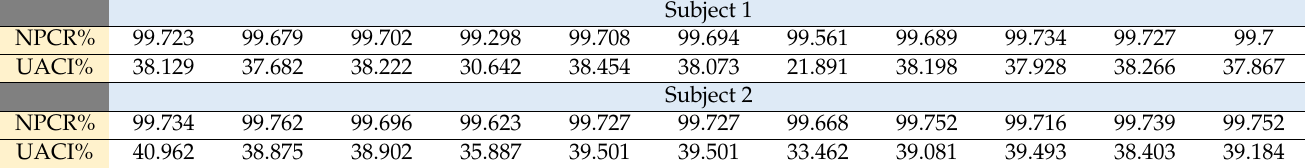
Table A1. Recorded NPCR and UACI values on Yale